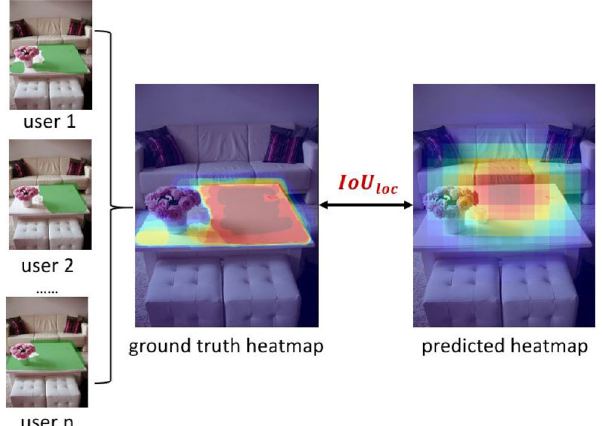
Fig. 7 Metric for heatmap. The heat value at each pixel represents the probability that it is contained within at least 1 insertable box. The average insertable region over all users is taken as the ground truth heatmap as a basis for comparison. This metric measures the system’s ability to approximate the hint provided by a